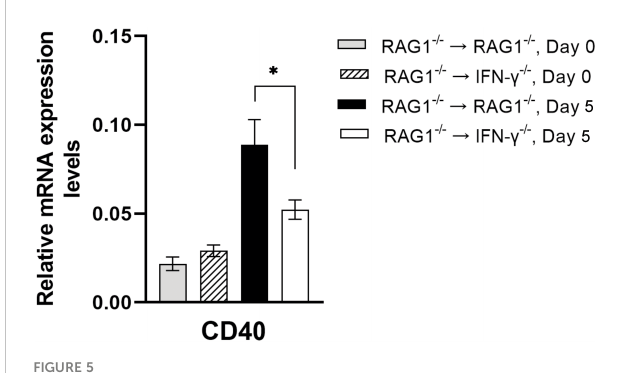
FIGURE 5 Cerebral mRNA levels for CD40, which activates intracellular killing of tachyzoites by microglia and macrophages, are upregulated by IFN- g production by brain-resident cells during reactivation of cerebral T. gondii infection. For the details of experimental methods, see the legend of Figure 1. The mRNA levels for CD40 were measured at both Day 0 and Day 5 in the brains of both groups of mice were measured using NanoString nCounter Mouse Myeloid Innate Immunity Panel. * P <0.05. The data were combined from two independent experiments (n=5 for Day 0 and n=7 for Day 5 in both RAG1 -/- → RAG1 -/- and RAG1 -/- → IFN- g -/-